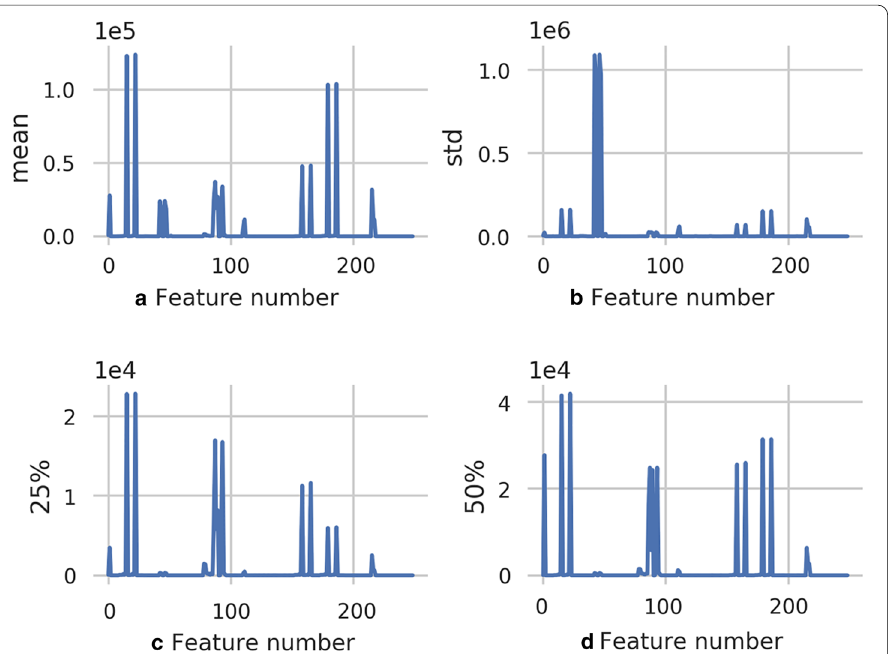
Fig. 3 Statistical characteristics of normalized data. a The mean values of features in the normalized dataset. b The standard deviation of features in the normalized dataset. c The 25% quartile values of features in the normalized dataset. d The 50% quartile values of features in the normalized